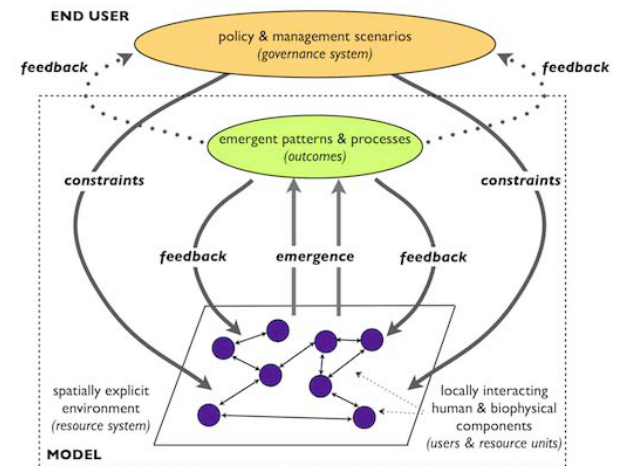
Fig. 2 . Simulation of a social-ecological system using a bottom-up approach. The model represents local interactions between human and biophysical components (users and resource units) in a regional landscape (resource system). These interactions give rise to emergent patterns and processes (outcomes) in the system. Components may re-organize or modify their behavior in response to emergent outcomes, giving rise to feedback loops within the system. As shown here, and in the three case studies presented in this article, the actions taken by the governance system, in the form of policy and management scenarios, are typically input to the model by a human